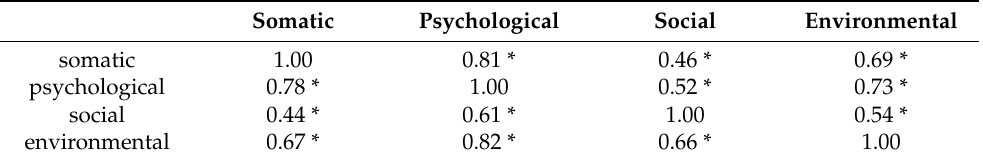
Table 6. Spearman’s correlation matrix of domain scores for the women before surgery (upper triangle) and for the women after surgery (lower